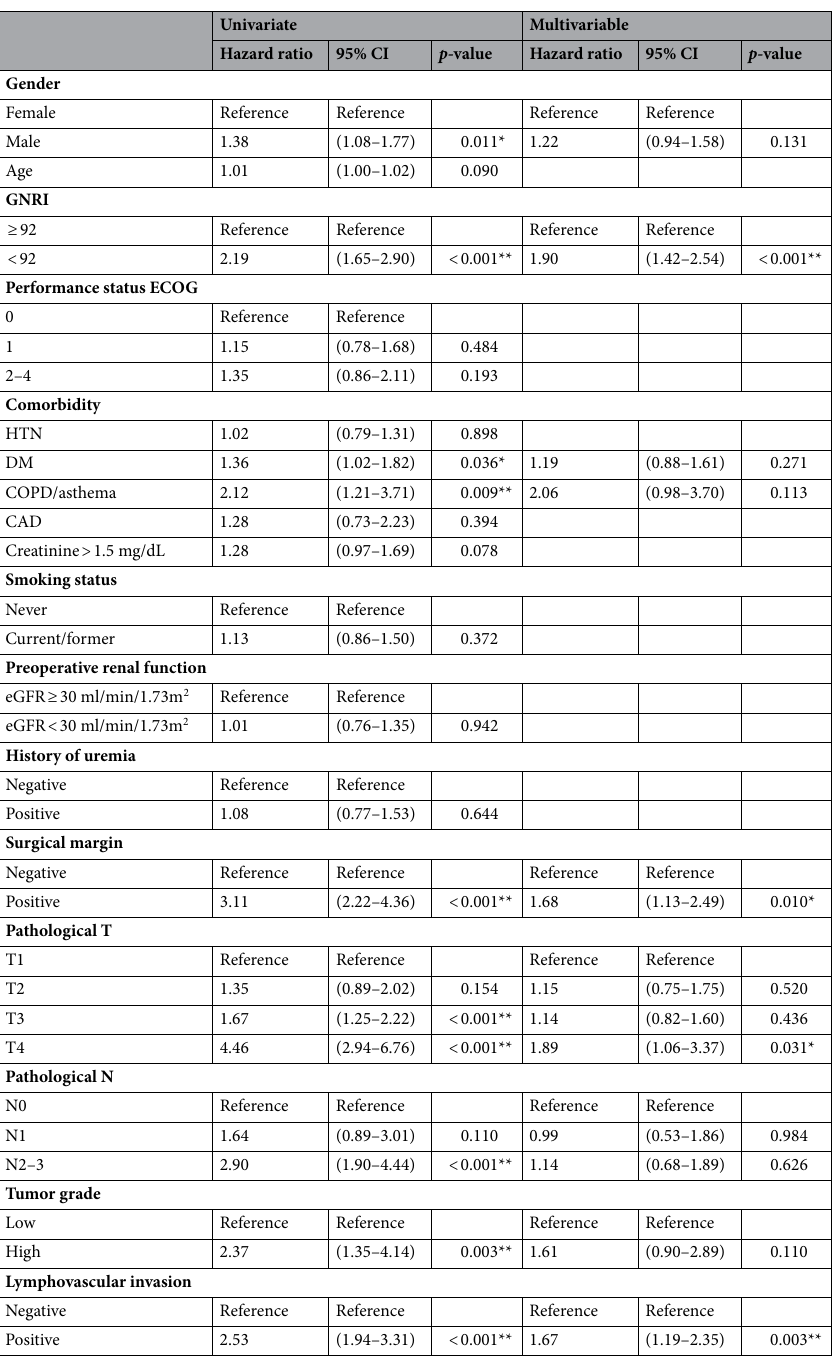
Table 4. Cox regression—disease free survival. GNRI geriatric nutritional risk index, ECOG Eastern Cooperative Oncology Group, HTN hypertension, DM diabetes mellitus, COPD chronic obstructive pulmonary disease, CAD coronary artery disease, eGFR estimated Glomerular filtration rate. Cox proportional hazard regression. * p < 0.05, ** p <